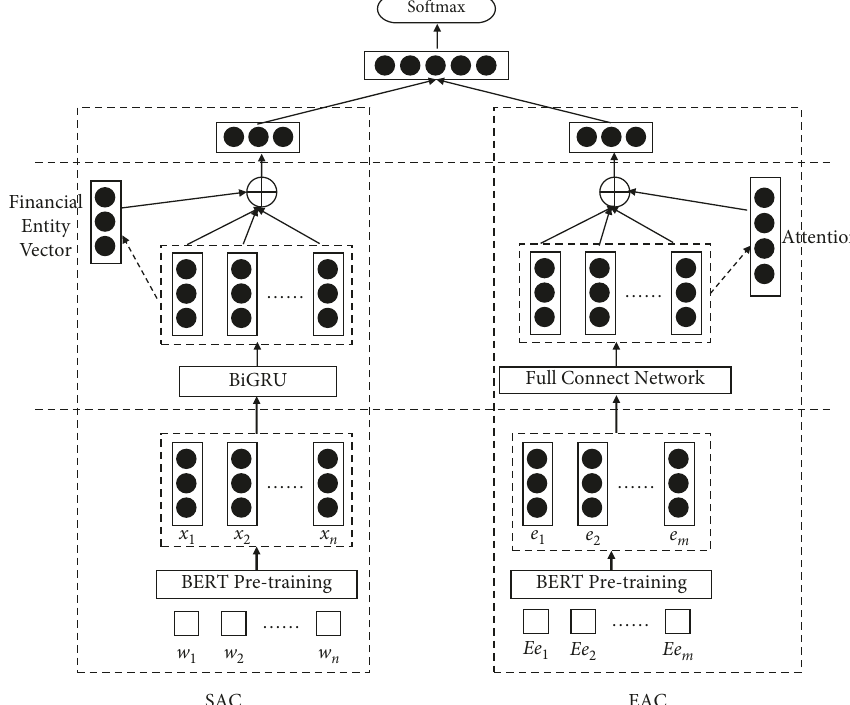
Figure 2: A model framework that combines sentiment dictionaries and attention.